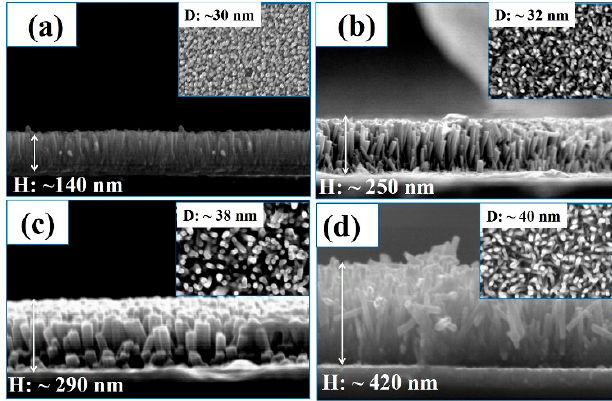
Figure 3. The scanning emission microscope of (top view (inset) and cross-section view) images of WA-ZnO Nrods grown on the ITO substrate with various reaction time of 1 to 4 h. ( a ) 1 h of growth time; ( b ) 2 h of growth time; ( c ) 3 h of growth time, ( d ) 4 h of growth time.